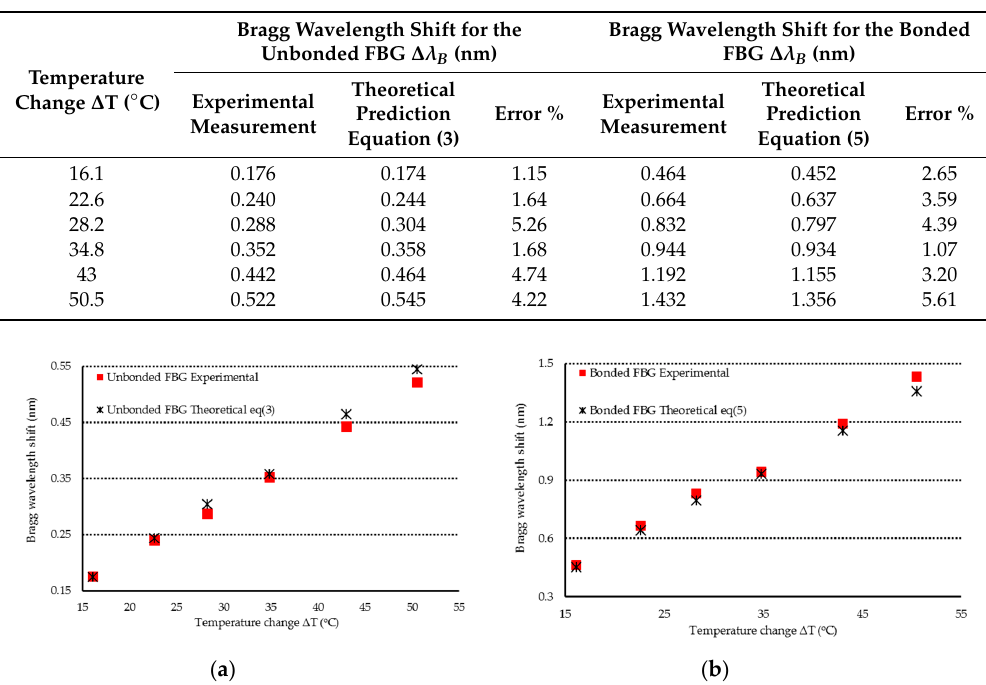
Table 2. Bragg wavelength shifts for the unbonded and bonded parts of FBG sensor due to the temperature change.